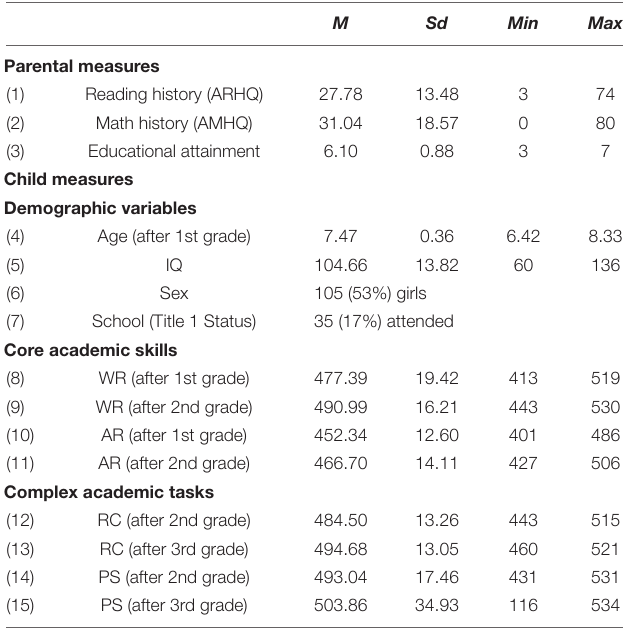
TABLE 2 | Descriptive statistics for the current longitudinal sample, including information on parental measures [reading history (ARHQ), math history (AMHQ), and educational attainment] and children’s demographic variables [age, IQ (at baseline), sex, and school information (Title 1 Status)], core academic skills [word recognition (WR) and arithmetic calculation (AR)], and performance on complex tasks [reading comprehension (RC) and problem solving